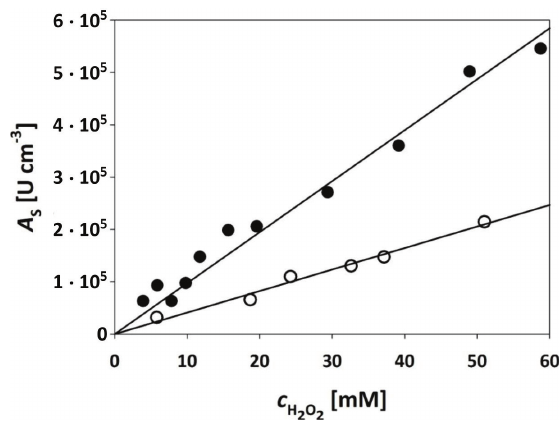
Fig. 3 – Kinetics of free (black circles) and immobilised (white circles) catalase in the reaction of hydrogen